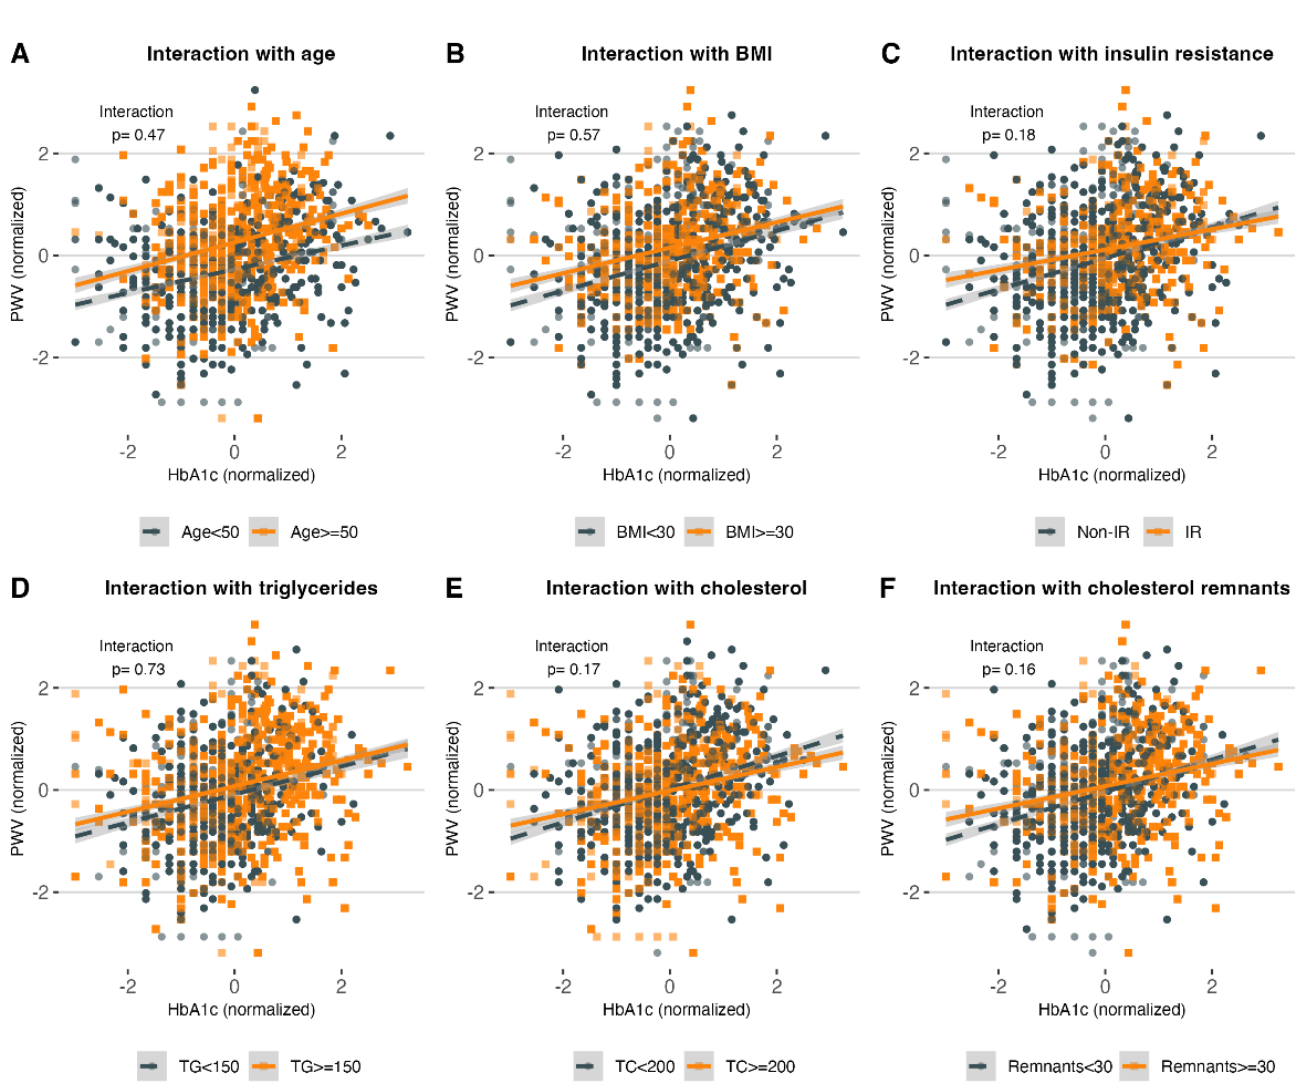
Figure A4. Interaction analysis to investigate the factors that modify the relationship between HbA1c and PWV. This relationship is not affected by age ≥ 50 ( A ), BMI ≥ 30 kg/m 2 ( B ), insulin resistance using METS-IR as a clinical surrogate ( C ), triglycerides ≥ 150 mg/dL ( D ), total cholesterol ≥ 200 mg/dL ( E ), or cholesterol remnants ≥ 30 mg/dL ( F ). Variables were standardized and normalized using the ordered quantile (ORQ) normalization of the BestNormalize R package.